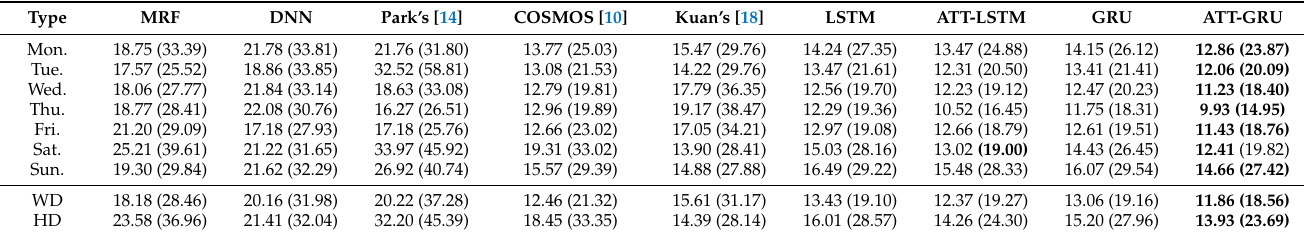
Table 10. MAPE (CVRMSE) comparison by date types for Building 1. WD and HD denote weekdays and holidays, respectively.